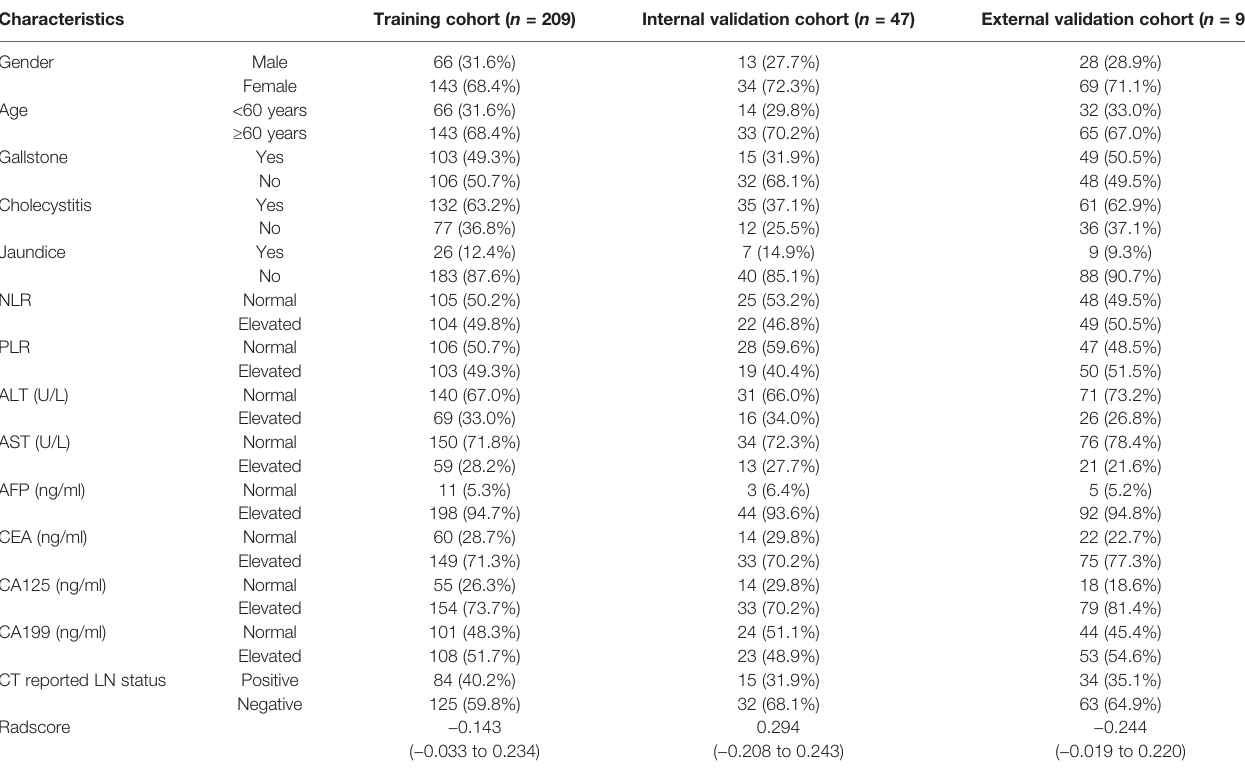
TABLE 1 | The clinical characteristics of the training cohort and the validation cohorts.